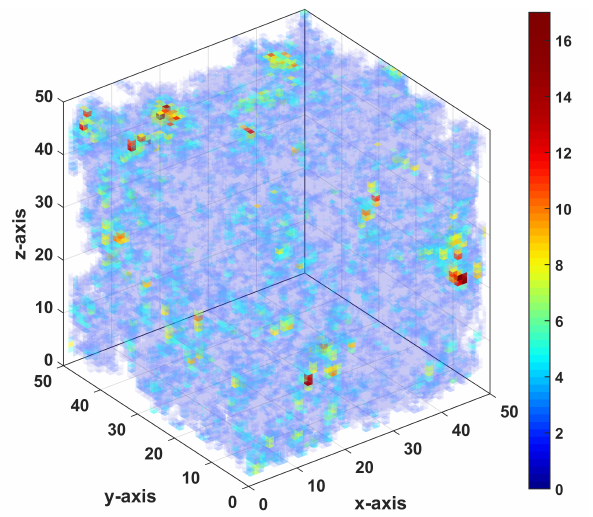
Figure 14. Color-coded simulation for the visits in each cell, for 60,000 iterations.